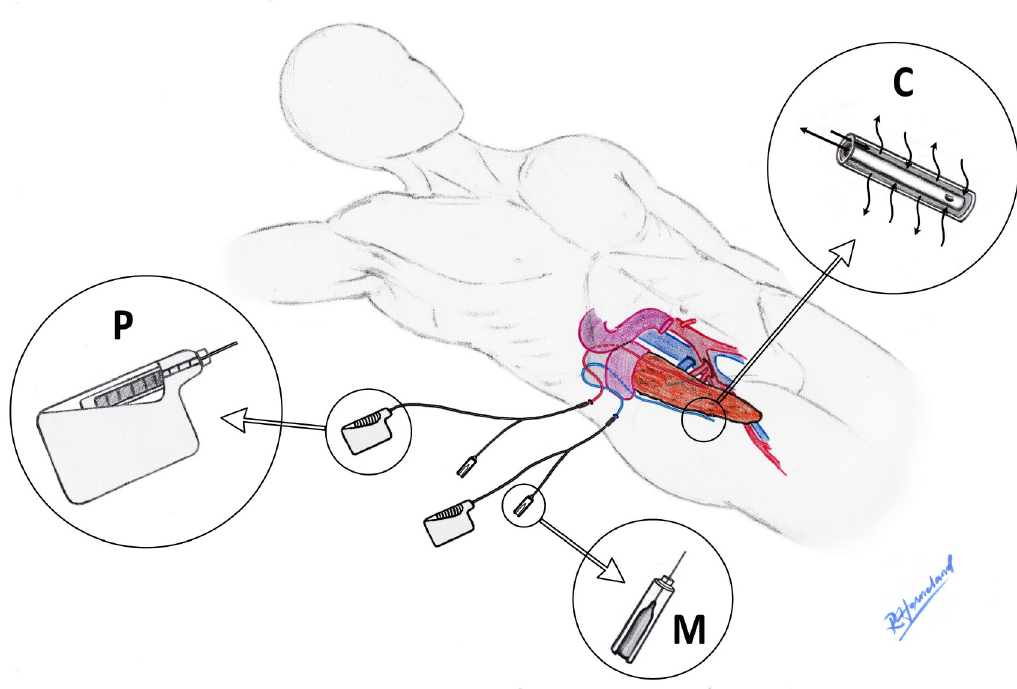
Fig 1. Consort flow diagram. The Consort flow diagram for the study. Template sourced from https://www.equator-network.org/wp-content/uploads/2013/09/ CONSORT-2010-Flow-Diagram-MS-Word.doc.